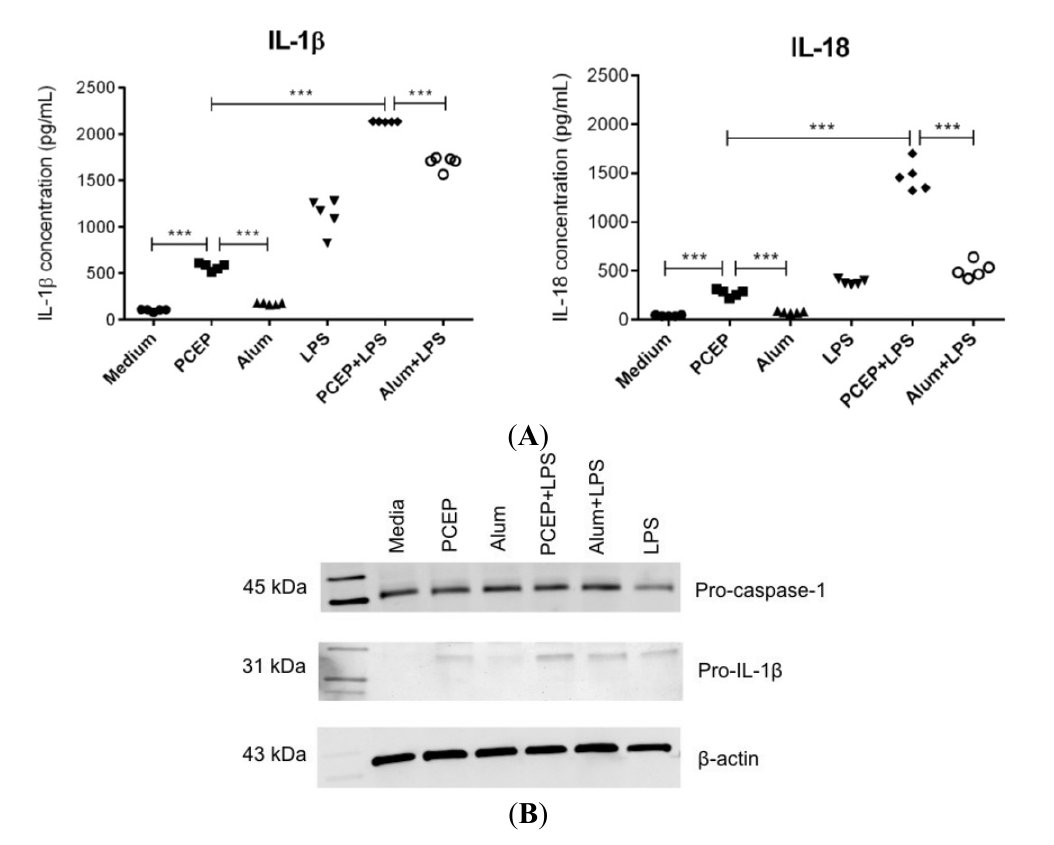
Figure 1. Poly[di(sodiumcarboxylatoethylphenoxy)phosphazene] (PCEP) induces robust secretion of IL-1β and IL-18 in splenic dendritic cells (DCs). Enriched splenic DCs from BALB/c mice were incubated for 12 h with media, PCEP (50 μg/mL), alum (40 mg/mL), lipopolysaccharide (LPS) (0.1 μg/mL), PCEP+LPS or alum+LPS. Supernatants were